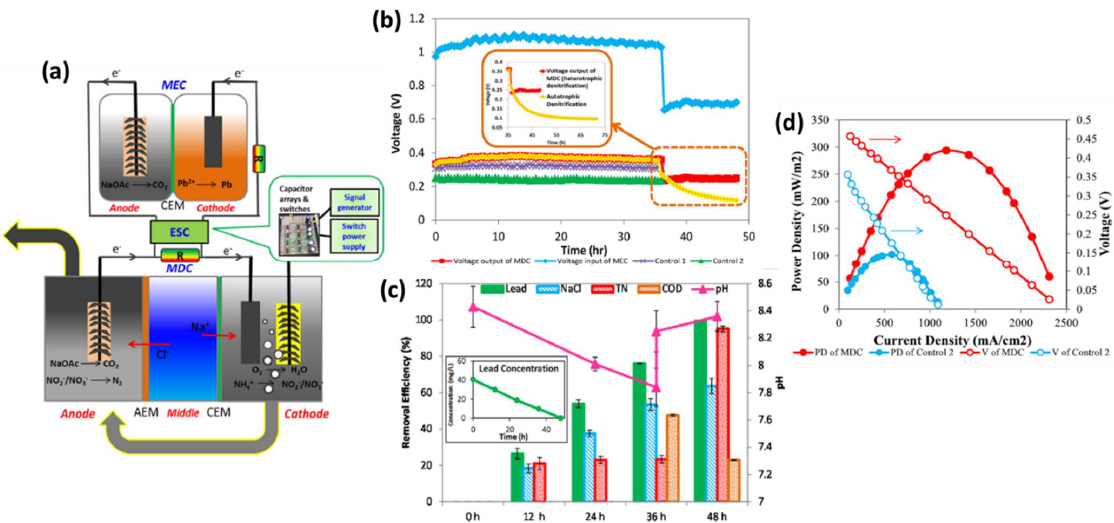
Figure 8. ( a ) The integrated MDC–MEC system diagram ( b ) Voltage changes of MDC output